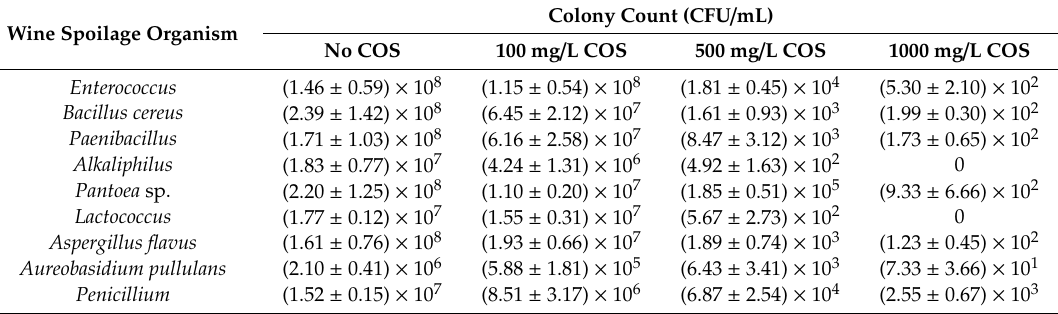
Table 1. The colony counts of nine types of spoilage organisms when applying 100, 500, and 1000 mg / L COS in the